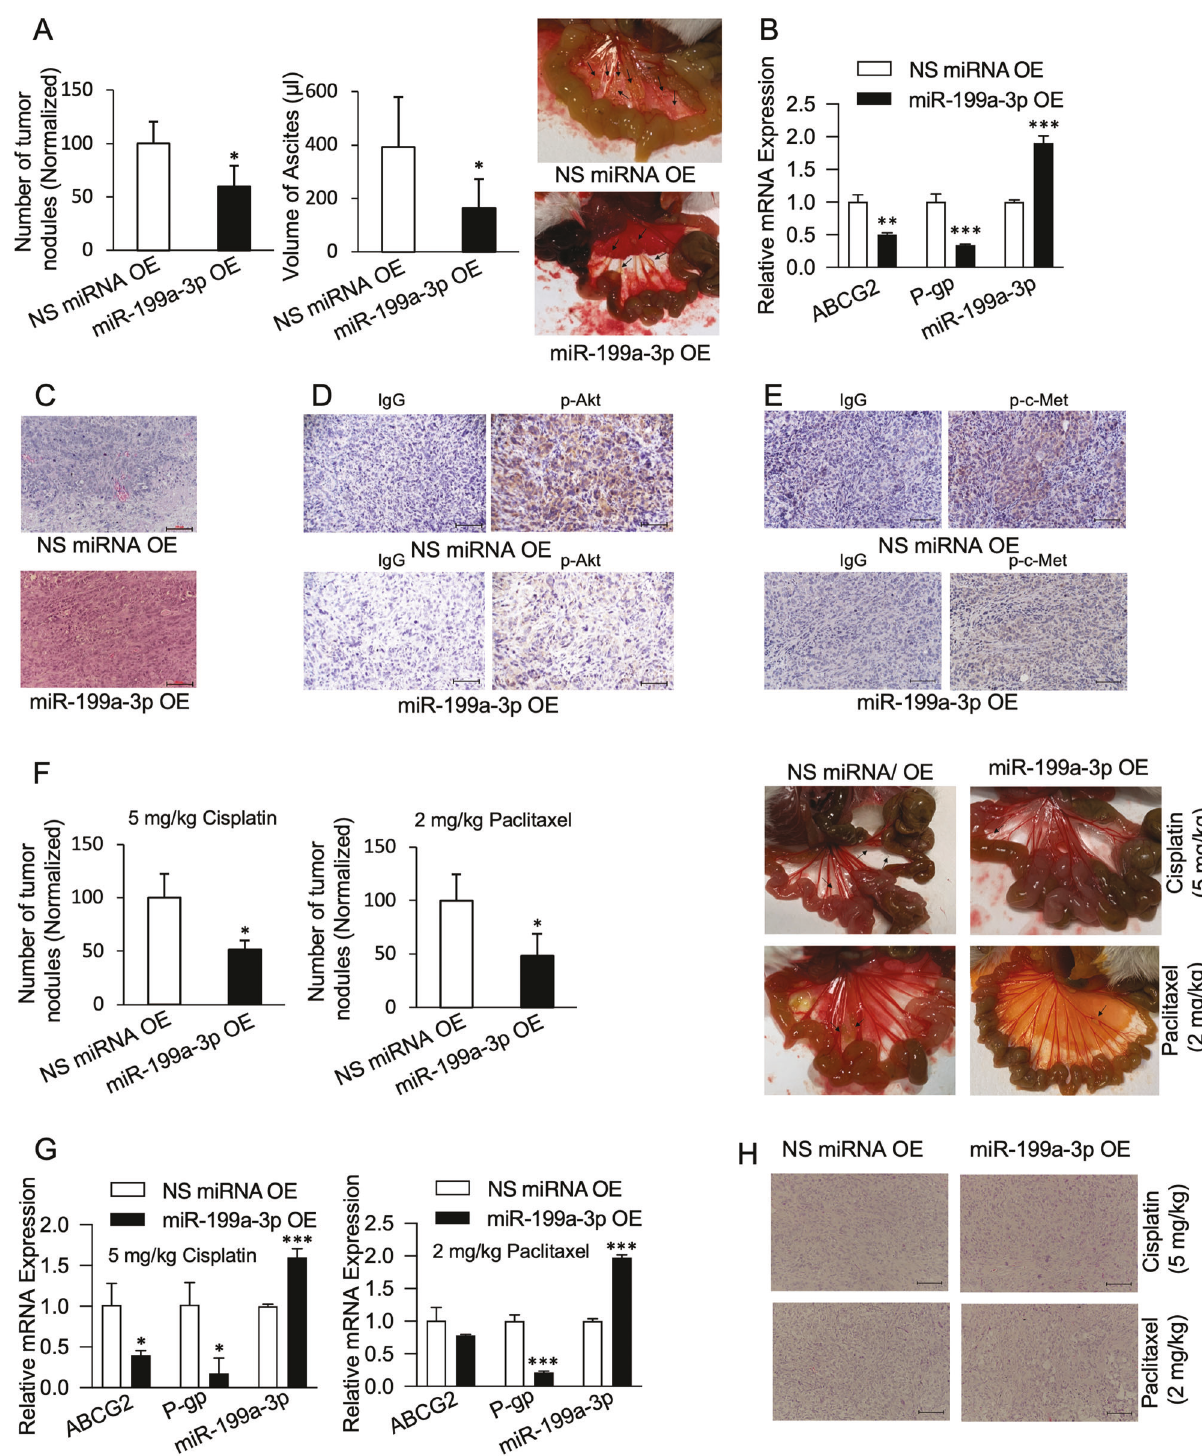
Fig. 6 miR-199a-3p reduces peritoneal dissemination of SKOV-3 cells and sensitizes them to cisplatin and paclitaxel. A Number of tumor nodules, volume of ascites, and representative image of tumor nodules. B Expression of ABCG2, P-gp, and miR-199a-3p from tumor tissue samples. C H&E, D p-Akt, and E p-c-Met staining of tumor tissue samples. F Number of tumor nodules and representative images for cisplatin and paclitaxel treated group. G ABCG2, P-gp, and miR-199a-3p expression, and H H&E staining after cisplatin/paclitaxel treatment. Scale bar, 100 μ m. Bar graph values are mean ± SD, n = 3. T -test. * P < 0.05, ** P < 0.005, *** P <